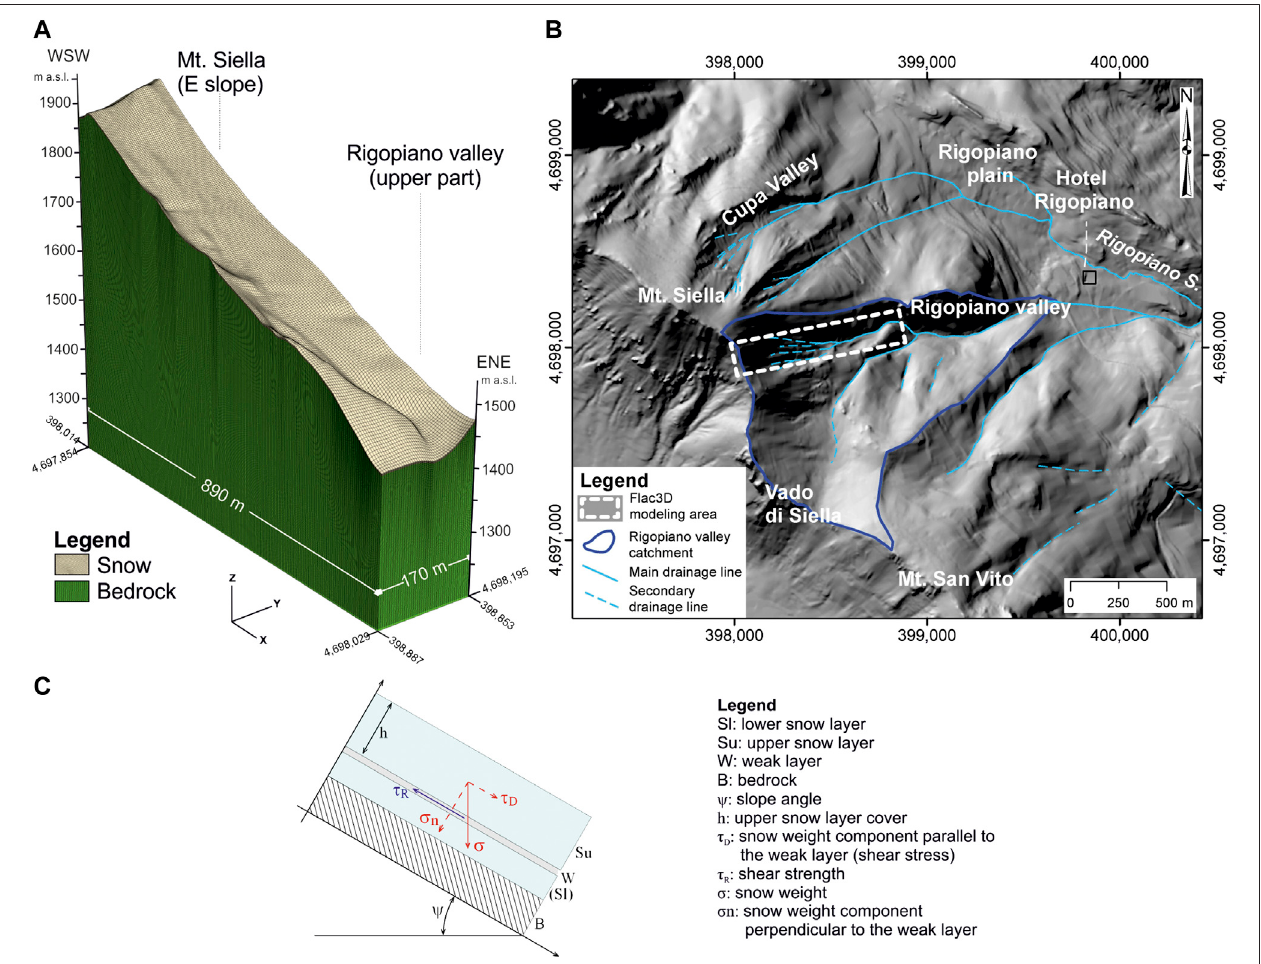
FIGURE4|(A) 3DmodeloftheupperpartoftheRigopianovalleyanddiscretizationgrid. (B) Locationofthemodel. (C) Simpli fi edschemeofthestrengthandstrain within the snow cover.